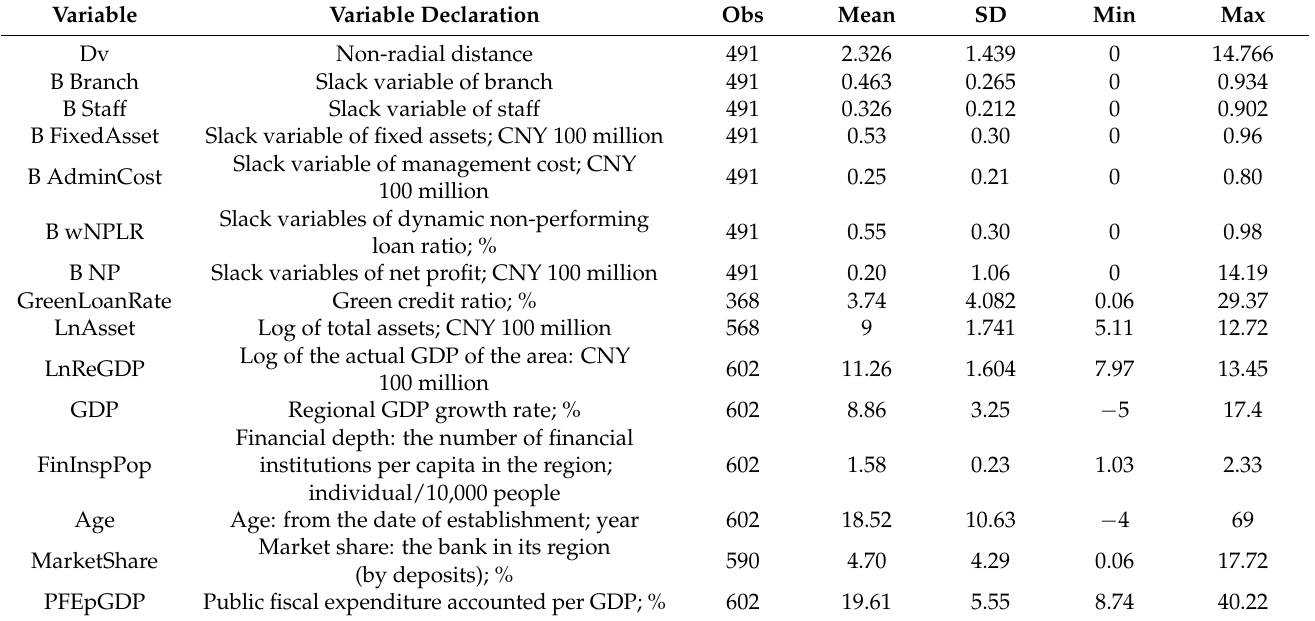
Table 5. Descriptive statistics (regression of green credit ratio and operating